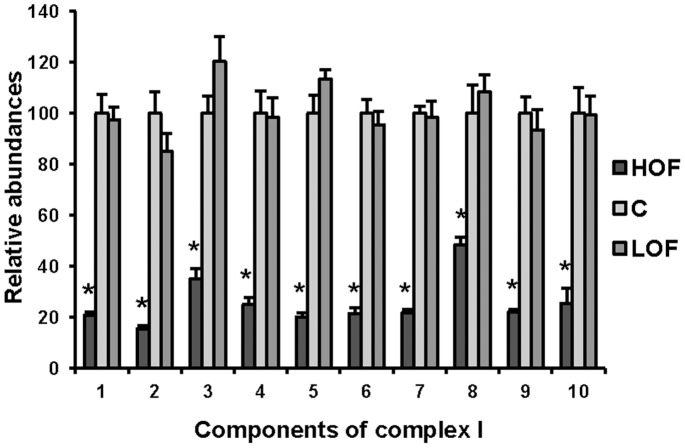
The differential mitochondrial proteins derived from iTRAQ were confirmed by the MRM analysis.The target proteins were selected base on the principles described in the text. The numbers 1–10 in the X axis represent targets as FBpp0071128, FBpp0074481, FBpp0088174, FBpp0078847, FBpp0077425, FBpp0077859, FBpp0070370, FBpp0072231, FBpp0087333 and FBpp0073949 (all from mitochondrial respiratory chain complex I), respectively. The Y axis indicates the abundance ratios of the individual targets that are normalized by the corresponding abundance of control. All the samples came from two biological replicates, and each sample was analyzed by MRM with triplicate. The calculation of abundance averages with standard deviations and the t-test were conducted with Excel (Microsoft Office 2010, USA). Black: HOF; Light gray: Control; Dark gray: LOF. All the abundances of components in HOF were significantly lower (* p<0.05, n = 6) than that of control and LOF.